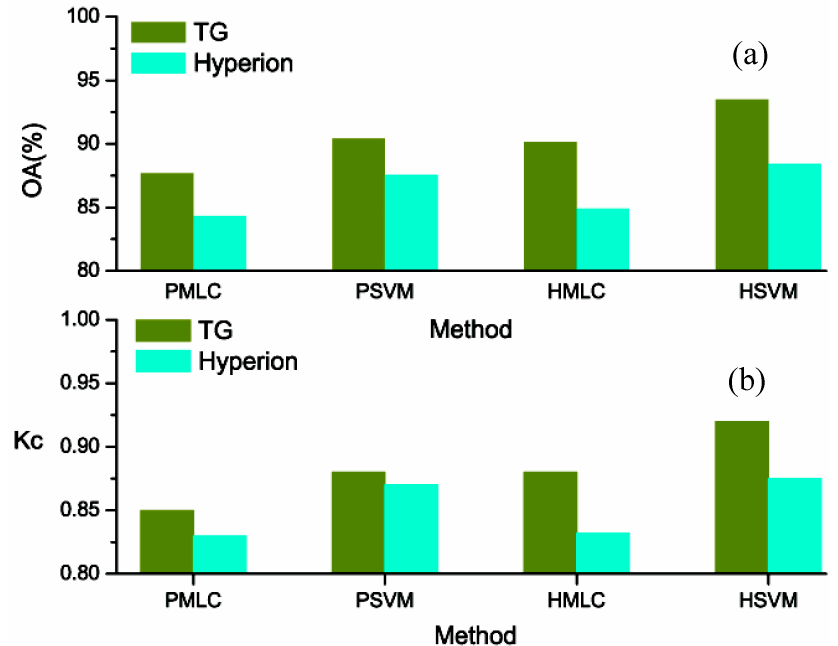
Figure 5. The average value calculated by five-fold cross validation method for the OA ( a ) and Kc ( b ) of the TG-1 and Hyperion images classified by using PMLC, PSVM, HMLC, and